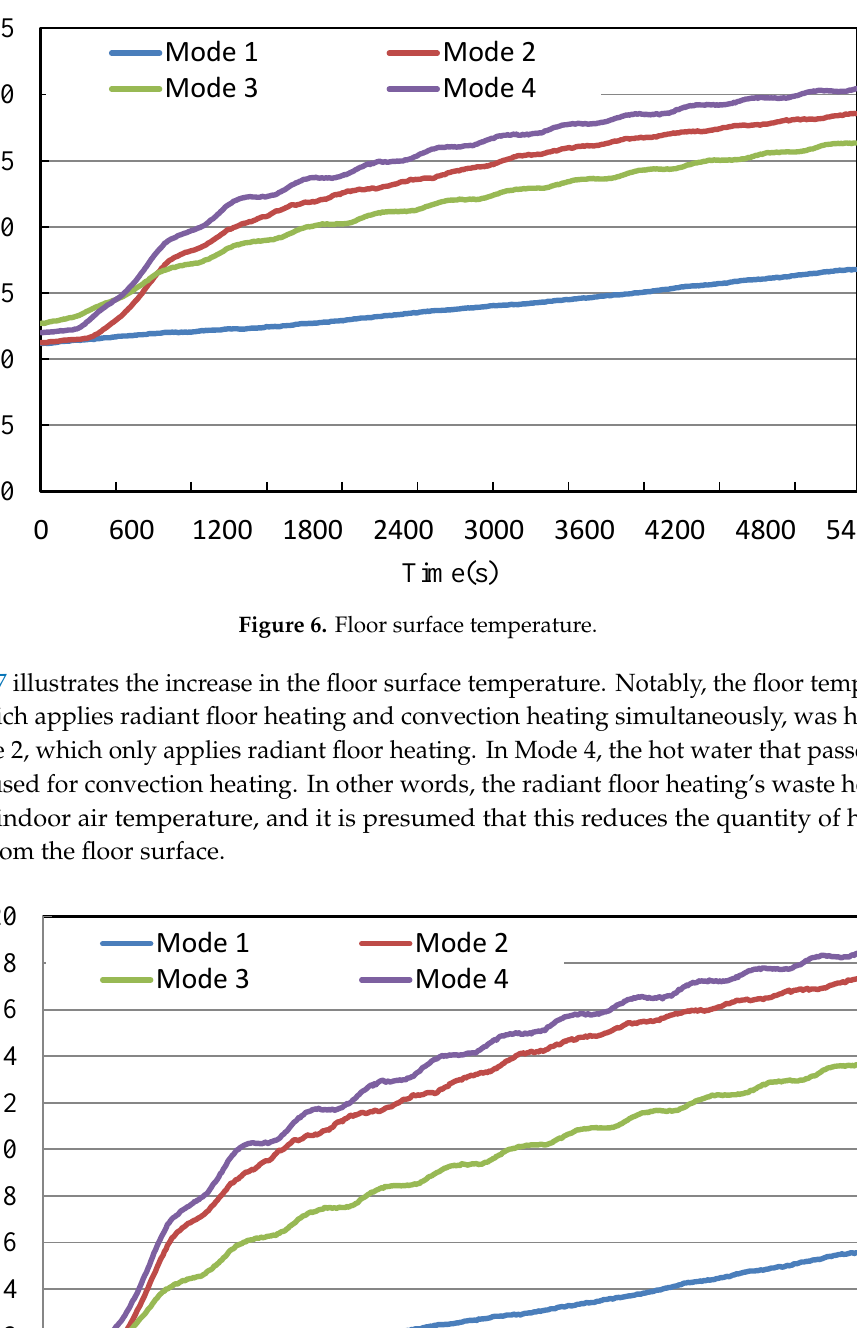
Figure 7. Floor surface temperature increase.